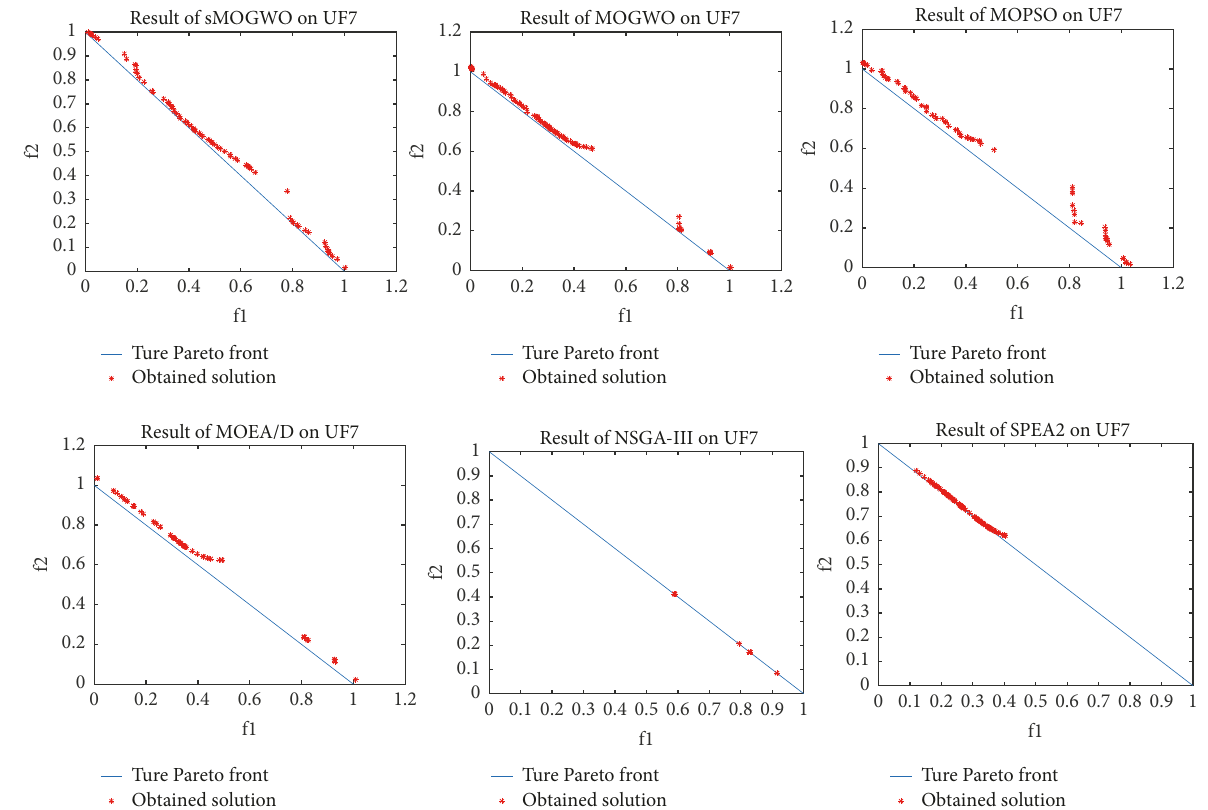
Figure 9: The best optimal results of the different algorithms in repeated experiments on UF7. Table 4: Some representative control strategies are chosen from the Pareto optimal solution set. Control